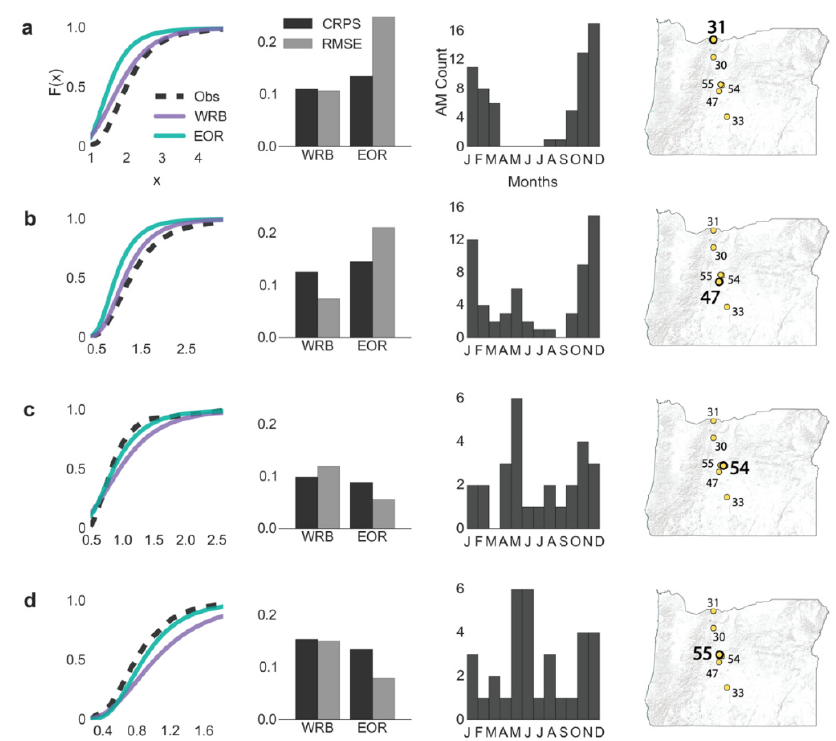
Figure 7. Comparison of the best model results at the overlapping stations. Each row of plots represents a single station, where row ( a ) is station 31, row ( b ) station 47, row ( c ) station 54, and row ( d ) station 55, as indicated by the map insets. Each includes, from left to right, the CDF of predicted versus observed annual maxima GEV distributions, CRPS and RMSE of each region’s model, the location’s AM climatology, and the location’s spatial placement within the study region.